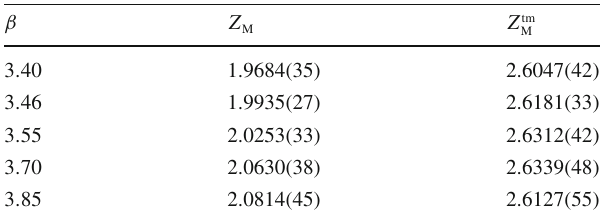
Table 5 Values of the renormalisation factors Z RGI and bare PCAC masses in the standard Wilson and twisted-mass cases, respectively, at the values of β for CLS ensembles. Recallthat the quoted errors do not contain the contribution from the running factor ) . The correlations between the errors at different β can be M / m (μ had readily obtained from the covariance matrices provided in Eqs. (5.6b) and (5.3b),